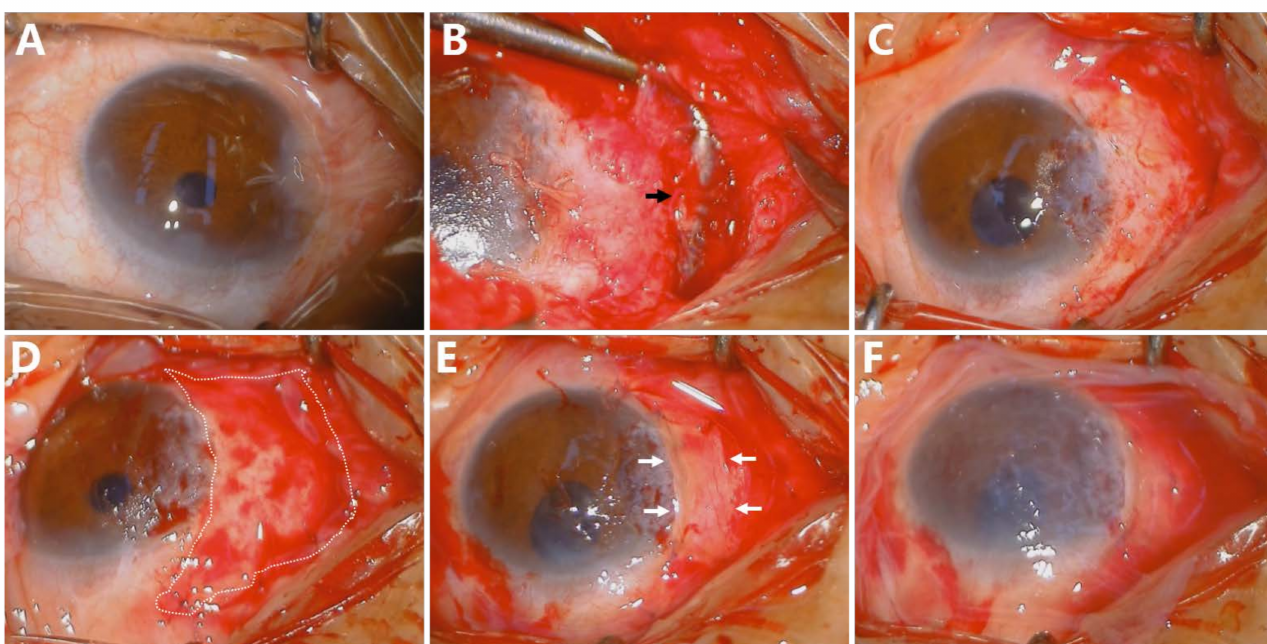
Figure 1. Surgical steps of Sandwich transplantation in recurrent pterygium with restrictive stra- bismus. Shows recurrent pterygium with restrictive strabismus pre-operation ( A ); Followed by dissection of pterygium. Medial rectus muscle was identified with a muscle hook ( Black Arrow ) ( B ); A sizeable conjunctival defect was remained after the removal of pterygium body and the scar tissue ( C ); The first layer of Amniotic membrane (white area) covered the bare sclera ( D ); CLAU was harvested, graft limbal side was aligned to the defect limbal side (( E ), White Arrows ); A large AM graft covered the ocular surface entirely ( F